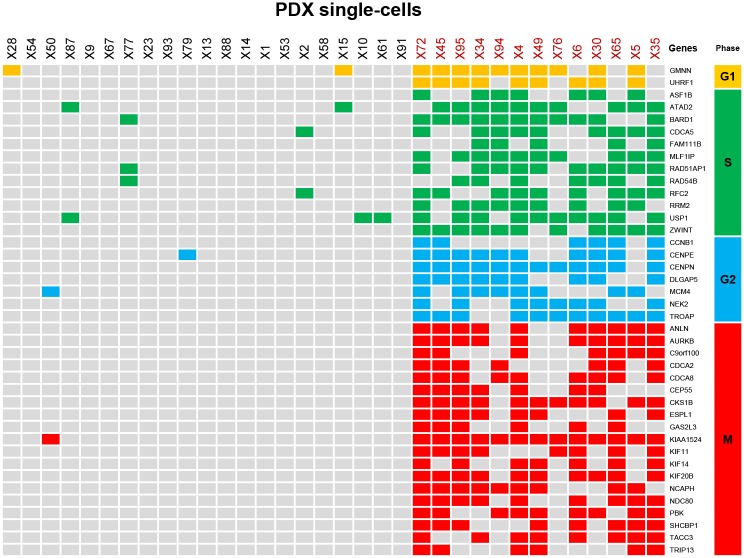
Cell-cycle regulation is a major functional class of G64 genes.A total of 40 genes in the G64 module were mapped to cell-cycle genes in CycleBase (http://www.cyclebase.org/). Each of the 40 cell-cycle genes was accordingly allocated to one of the cell-cycle stages (e.g., G1, S, G2, or M, colored in yellow, green, blue, and red, respectively).